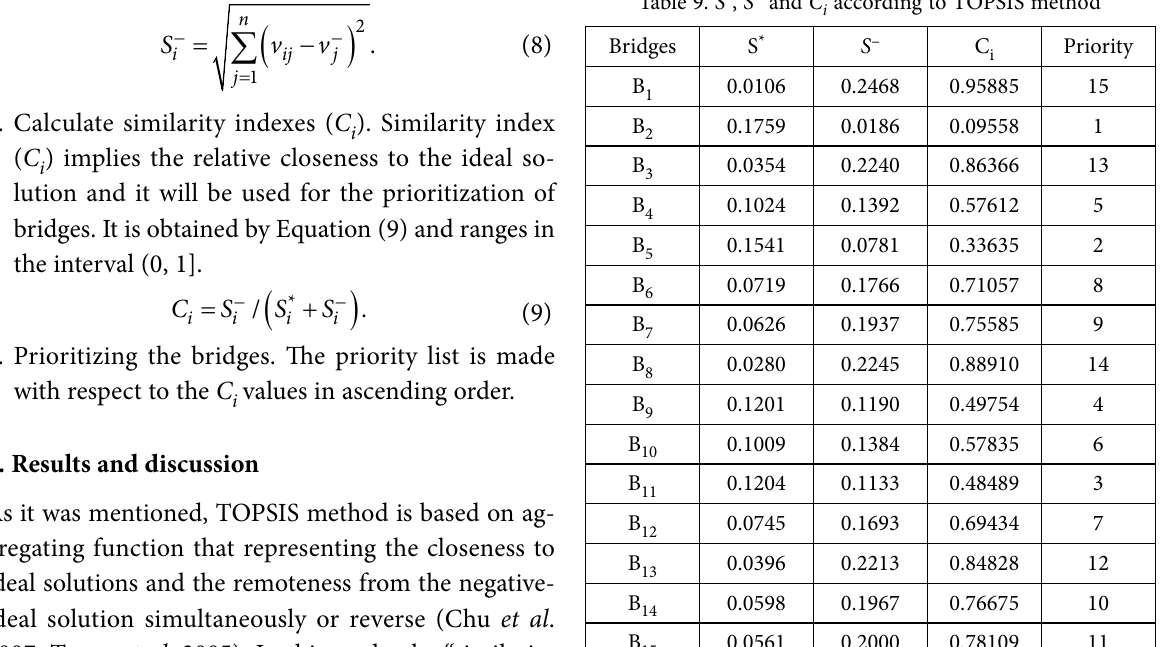
Table 9. S * , S – and C